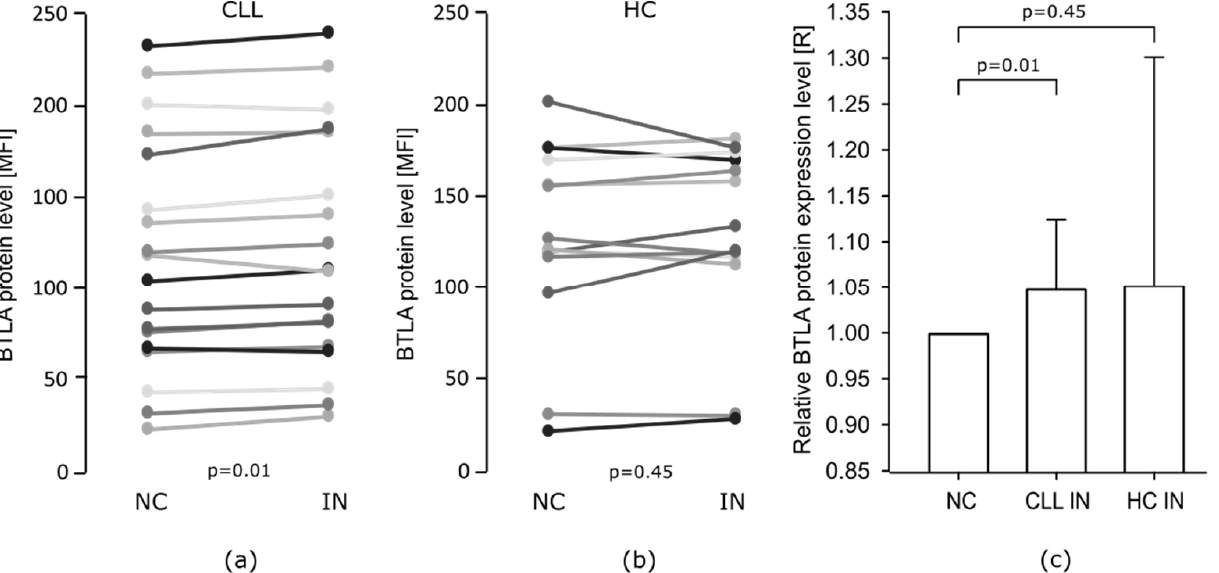
Figure 4. Effect of miR-155-5p inhibition on BTLA protein level in CD19+BTLA+ cells. ( a , b ) Flow cytometric analysis of BTLA protein level on CLL CD19+BTLA+ cells ( n = 19) and healthy controls (HC) CD19+BTLA+ cells ( n = 15) transfected with miR-155-5p NC or IN; ( c ) Inhibition of miR-155-5p increases BTLA protein level on CLL CD19+BTLA+. Relative protein expression level (R) was calculated for every patient as a fold change in MFI level after treatment with miR-155-5p IN compared to miR-155-5p NC (R = MFI of IN/MFI of NC). The graphs represent mean and SD of the results of all individuals in each group. IN—inhibitor, NC—negative